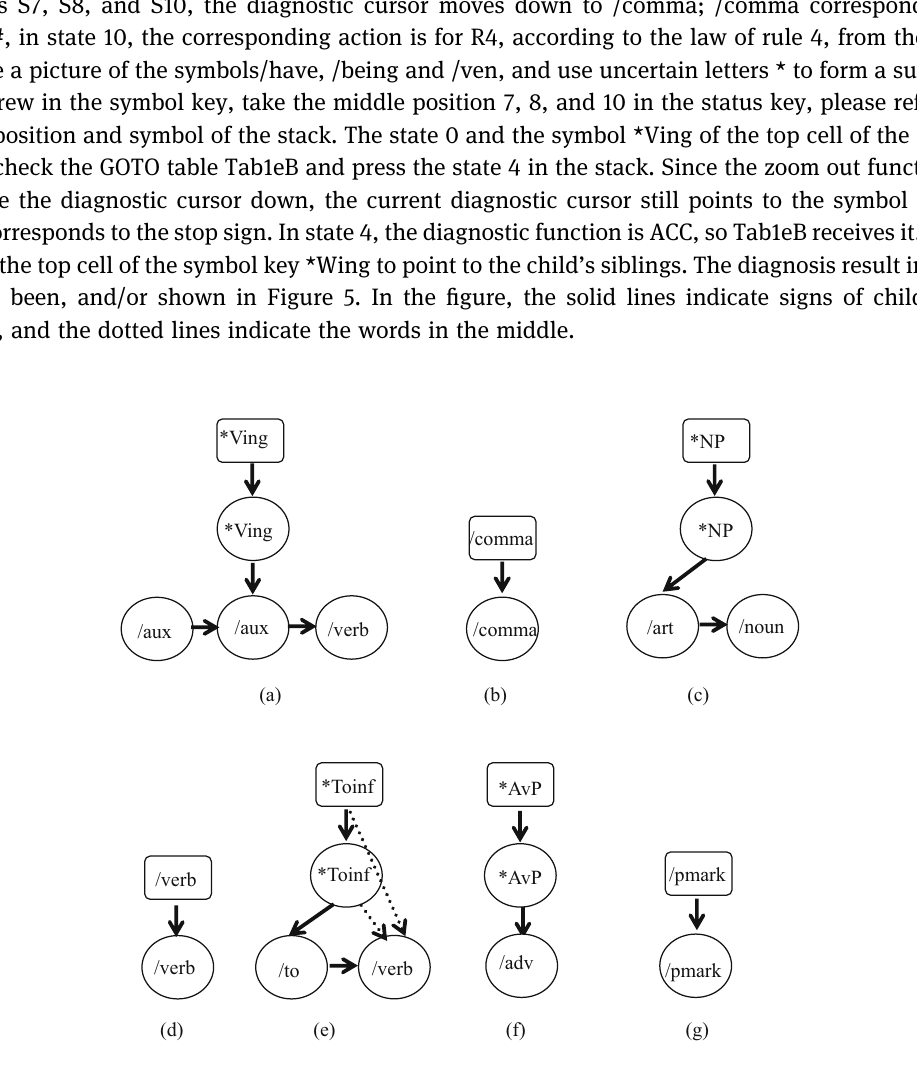
Figure 5: The analysis result of the symbol/comma ( a – g )